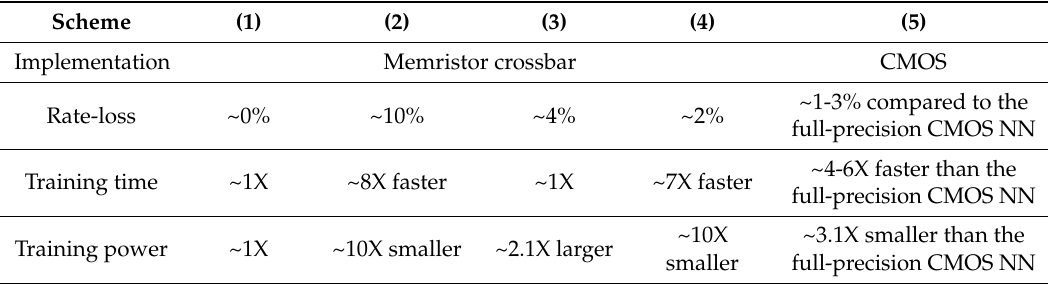
Table 2. Comparison of the loss of MNIST recognition rate, training time, and training power, among four memristor-crossbar-based schemes and one CMOS-based Quantization Neural Network (QNN). The five schemes are as follows. (1) The memristor crossbar implemented from the 6-bit NN with 100%-retraining. (2) The memristor crossbar implemented from the network’s pruning algorithm, refered in [18,19]. (3) The memristor crossbar implemented from QNN algorithm, refered in [32–34], (Memristor Binarized NN [24]). (4) The proposed partial gating scheme. (5) CMOS-based QNN, refered in [35]. In the crossbar simulation with MNIST dataset, the same defect map and the same percentage of defects = 10% are assumed. The non-ideal parasitic resistance values are R S = 0.27%-R HRS and R N = 0.067%-R HRS that are the same values with Figures 7 and